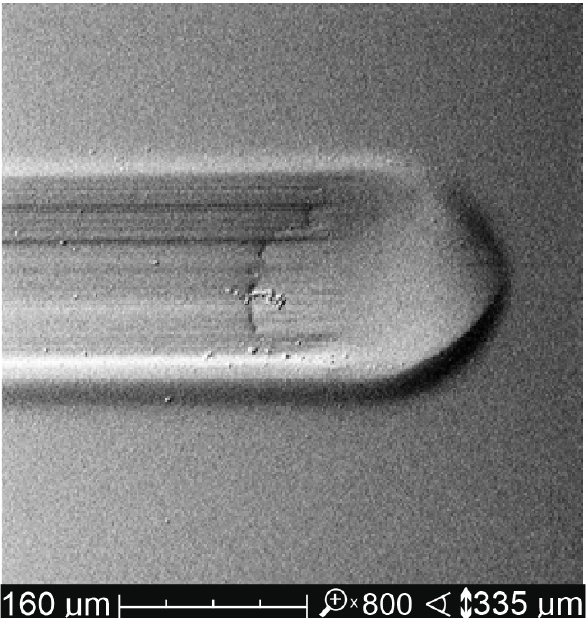
Figure 4. SEM image of topographic pile-up of the polymer material.